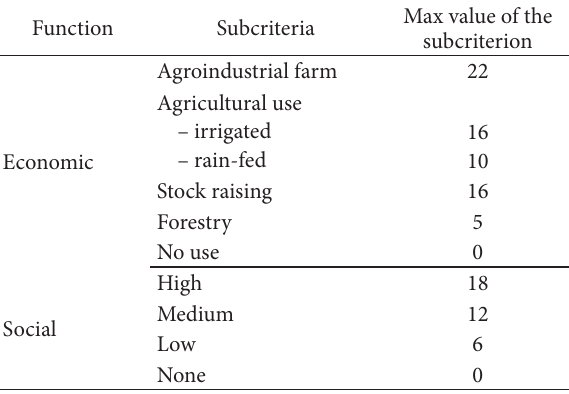
Table 2 . Max values assigned to economic and social functions in the classification of low-volume roads with respect to